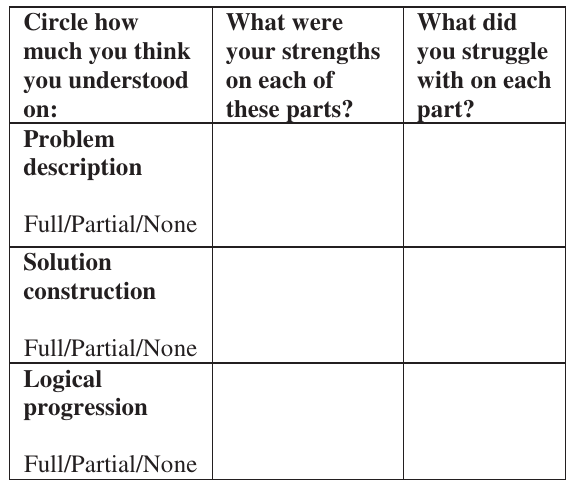
FIG. 2. Adaptation of the rubric used in Yerushalmi et al. (2012a-b) for the individual metacognition portion of the prob- lem-solving exercise. From Ref.